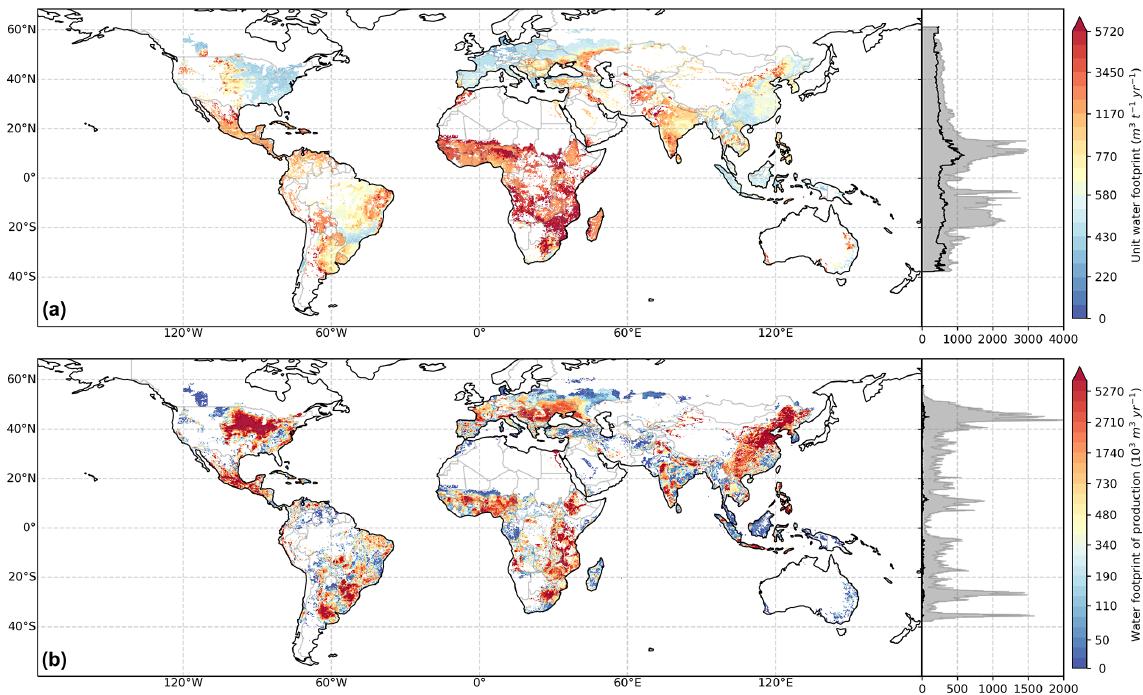
Figure 4. Unit water footprint (a) (m 3 t − 1 yr − 1 ) and water footprint of production (b) (10 3 m 3 yr − 1 ) of maize as the average over 2012–2016 at 5 × 5arcmin resolution. The grey area in the side chart represents the median of all data points along the respective latitude, and the black line is the 10th